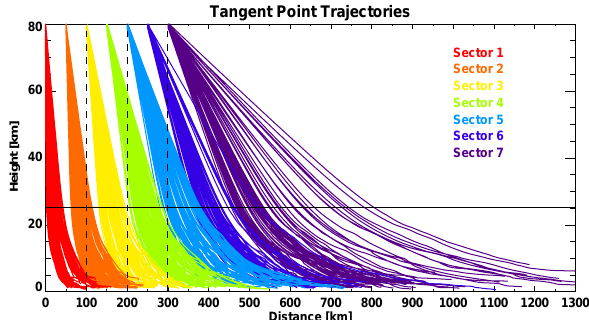
Fig. 2. Horizontal movement of the tangent points with decreasing Figure 2. Horizontal movement of the tangent points with decreasing height for the seven height for the seven azimuth sectors (shifted by multiples of 50km azimuth sectors (shifted by multiples of 50 km for better separation). for better